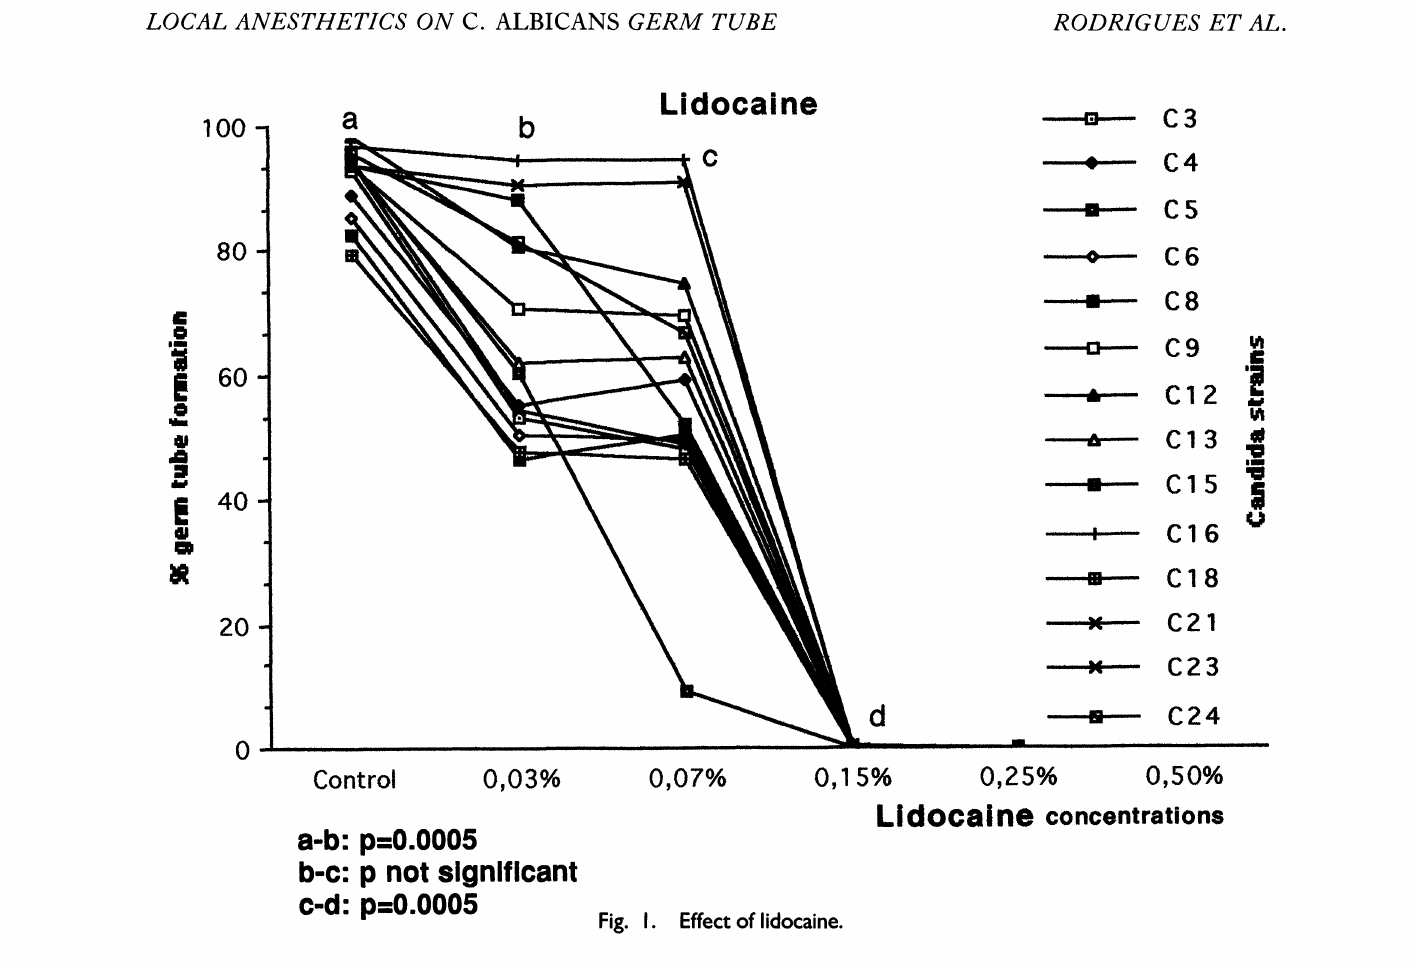
Fig. I. Effect of